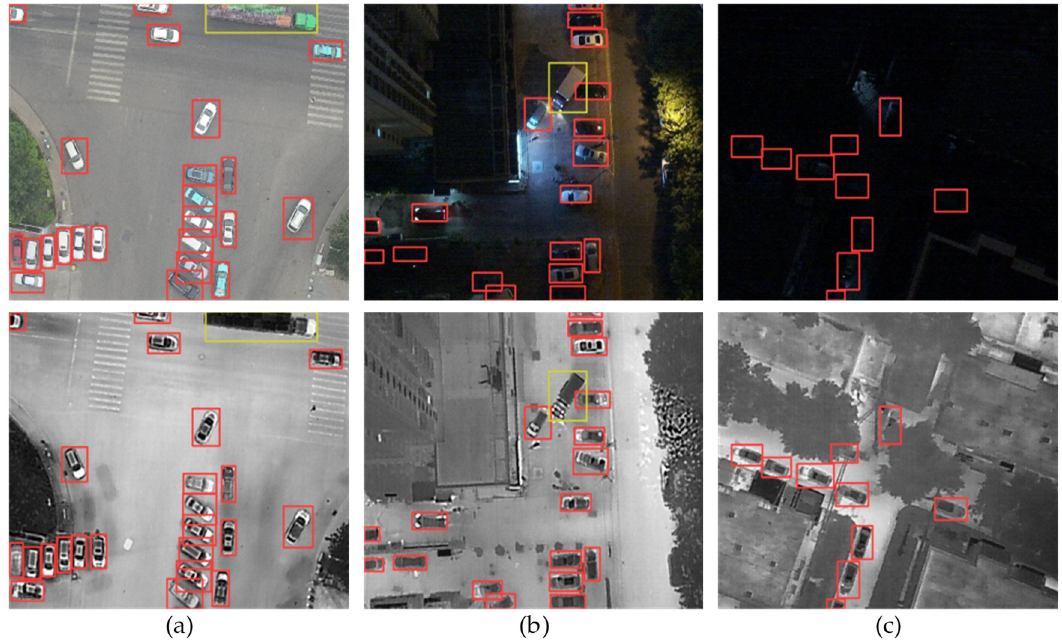
Figure 7. Visualization of images in the DroneVehicle dataset. ( a ) Day scene. ( b ) Night scene. ( c ) Dark night scene.